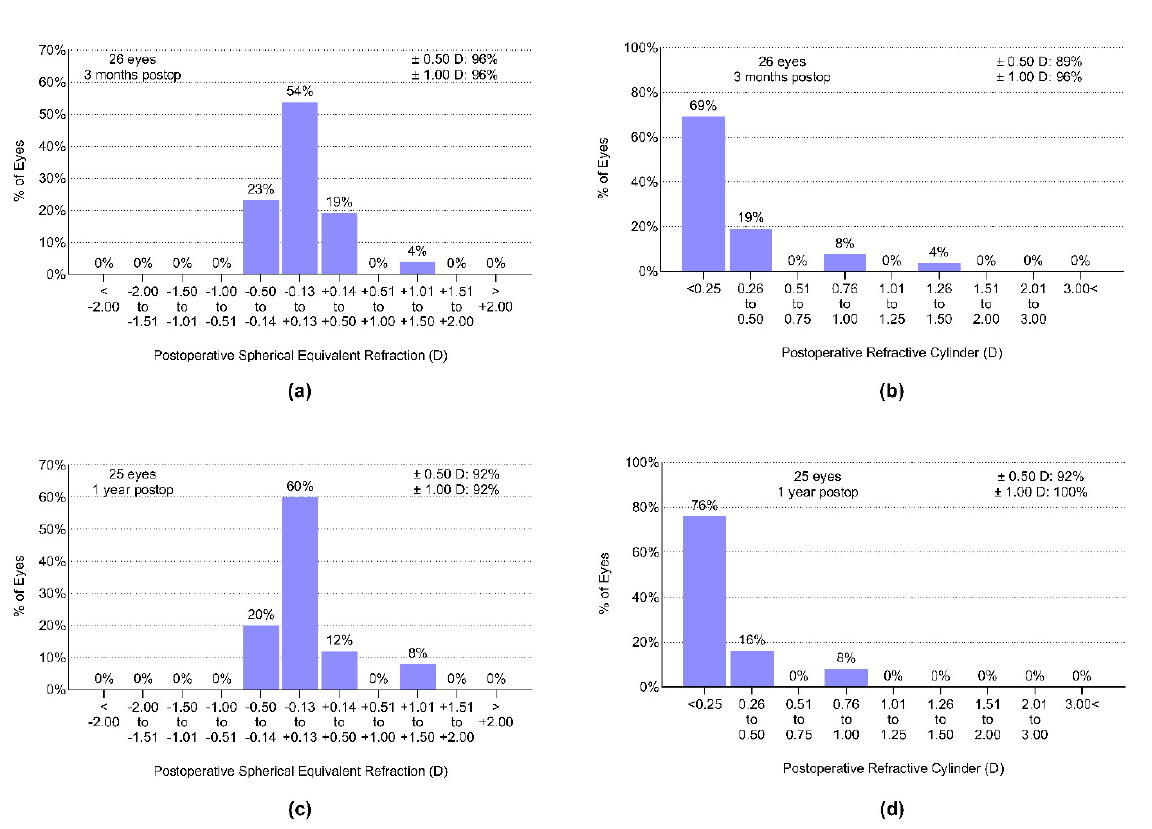
Figure 3. Double-angle plots of preoperative ( a ) and refractive astigmatism ( b ) and of the prediction error ( c ) measured and calculated one year after surgery. 3.3. Rotational Stability of the IOL The rotational stability was determined by comparing the position of the toric marks of the IOL at each postoperative visit to the surgical position of the lens. There was no need for repositioning in any of the cases. Table 2 presents the average signed and absolute rotations during each postoperative visit. While the signed rotation takes the direction of the rotation into account, the absolute rotation disregards the direction and only considers the magnitude of rotation.